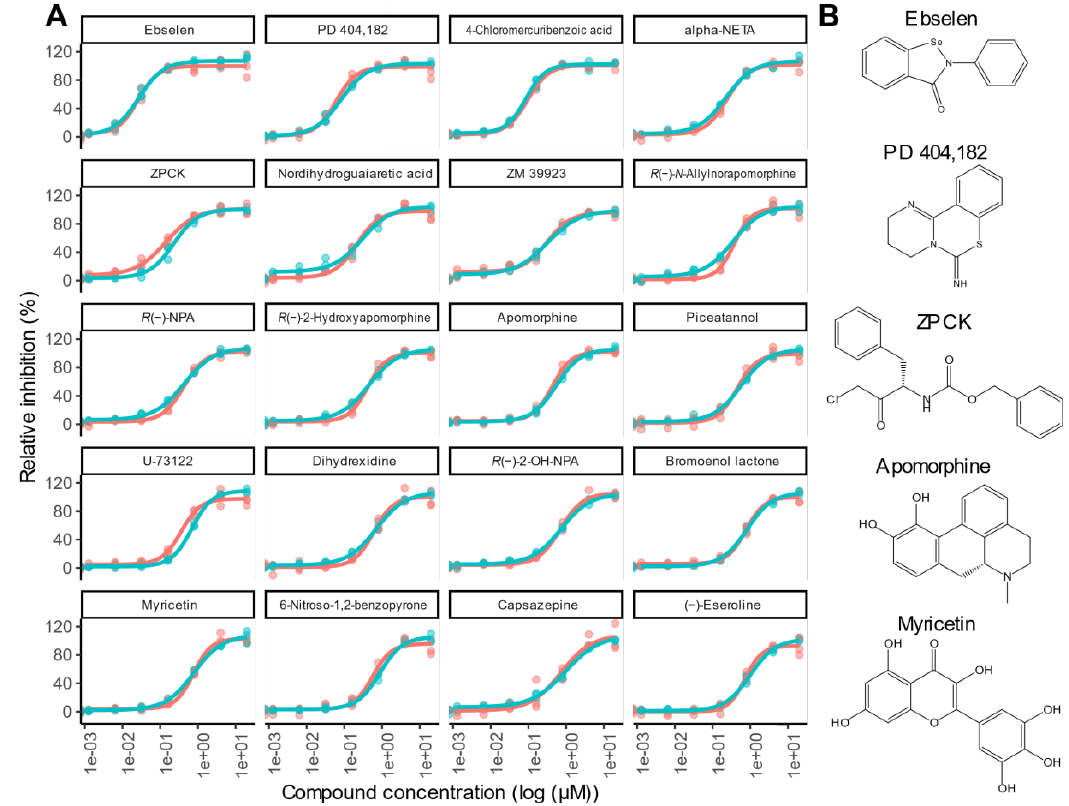
Figure 5. Dose–response curves for the top 20 inhibitors identified in this study and selected structures for compounds discussed in the text. ( A ) Dose–response assays were performed both with (blue) and without (red) 0.01% Triton X-100. Each compound was assessed across a 5-fold serial dilution series starting at 20 µM. Relative inhibition was calculated using the average R 528/477 for the protease treated controls as 0% inhibition and the average R 528/477 for the no protease controls as 100% inhibition. Experiments were performed in triplicate using a different preparation of purified eCFP-Venus biosensor for each repeat. EC 50 values were calculated using the R package ‘dra’ [16], and all data points are shown. ( B ) Structures of five compounds that are discussed further in the text. Compounds tested in this Panel A are: Ebselen; PD 404,182; 4-Chloromercuribenzoic